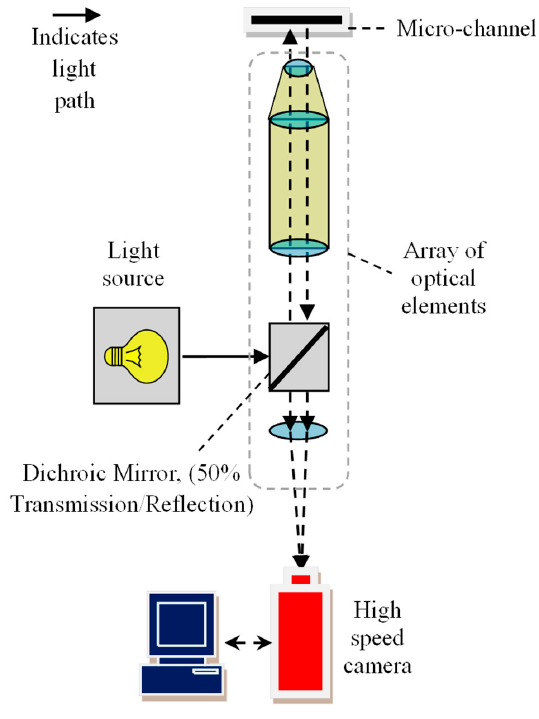
Figure 4. Schematic diagram of optical setup.